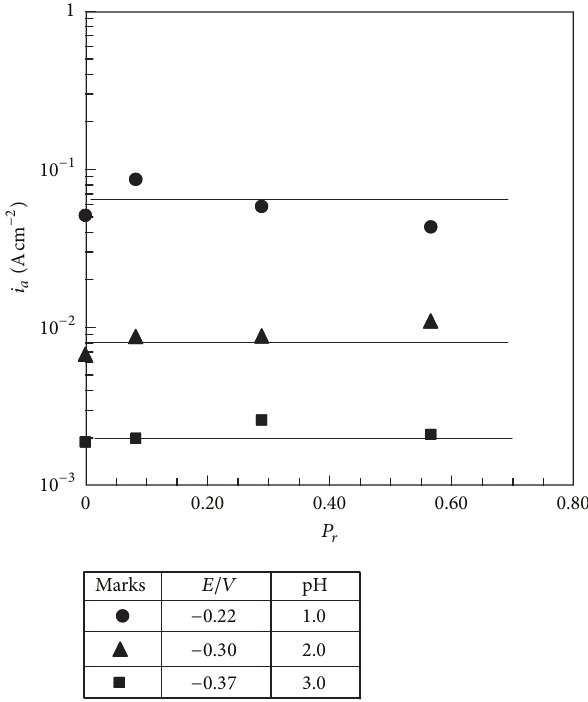
Figure 6: Anodic current densities as a function of the ratio of the pearlite area, 𝑃 𝑟 , at a few constant electrode potentials and